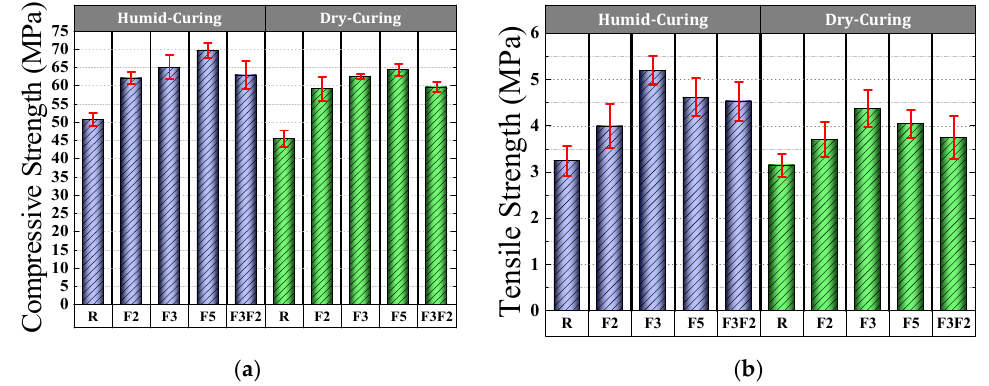
Figure 10. Strength of the concrete mixes: ( a ) 28 days compressive tensile strength; ( b ) 28 days split tensile strength.